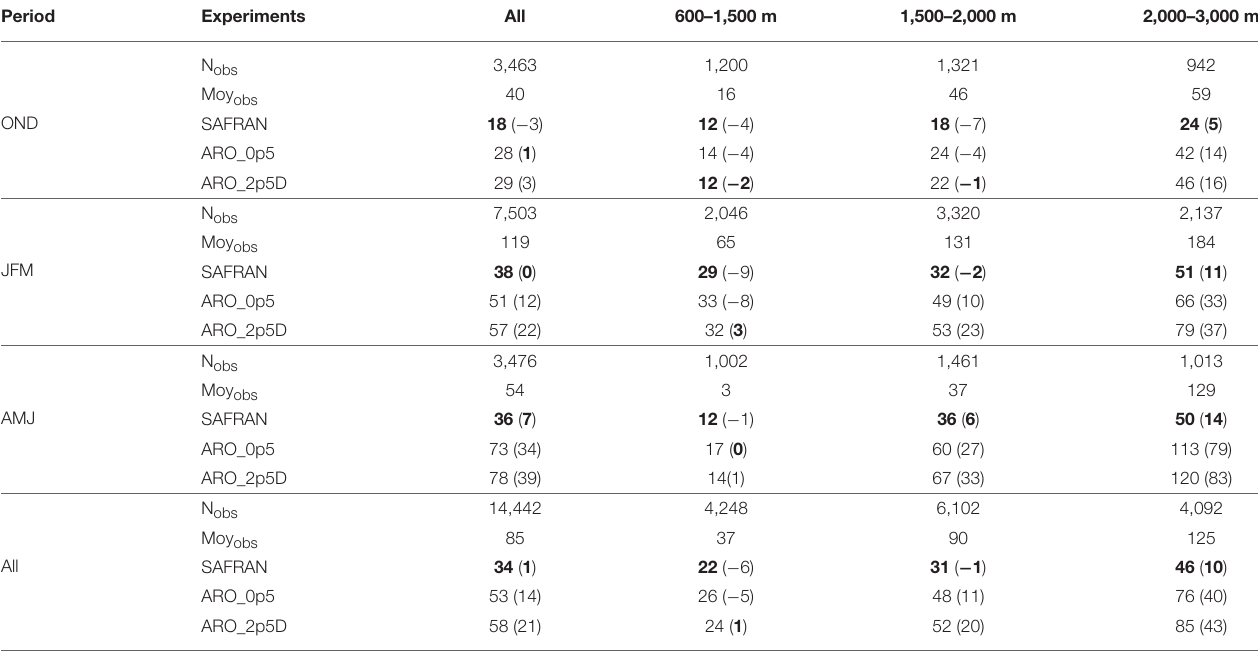
TABLE 2 | Error statistics (in cm) for simulated snow depth against observations for winter 2011-2012 for four time periods: (1) October–December (OND), (2) January–March (JFM), (3) April–June (AMJ), and (4) over the entire snow season (All).